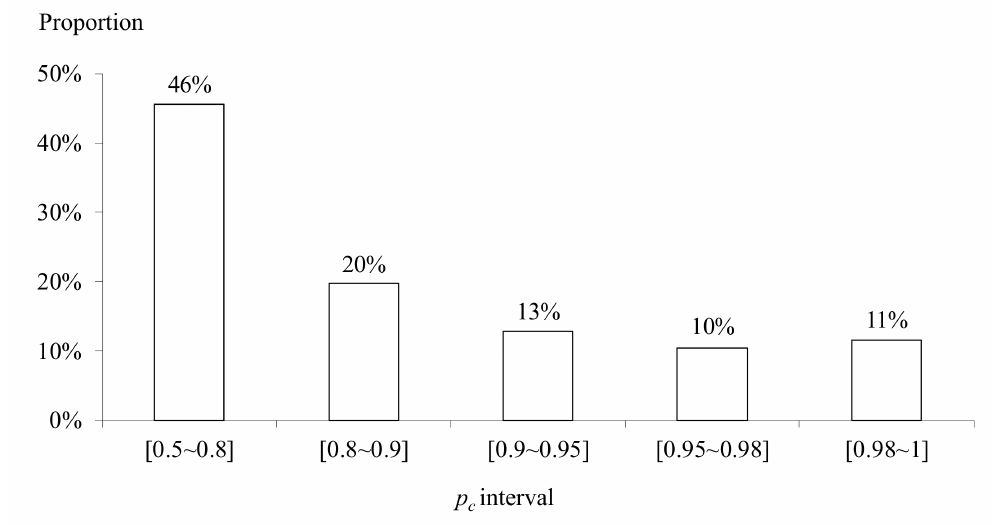
Figure 7. Distribution of the values of p c during the search for an optimal solution of the Ackley function ( σ = 0.1) by